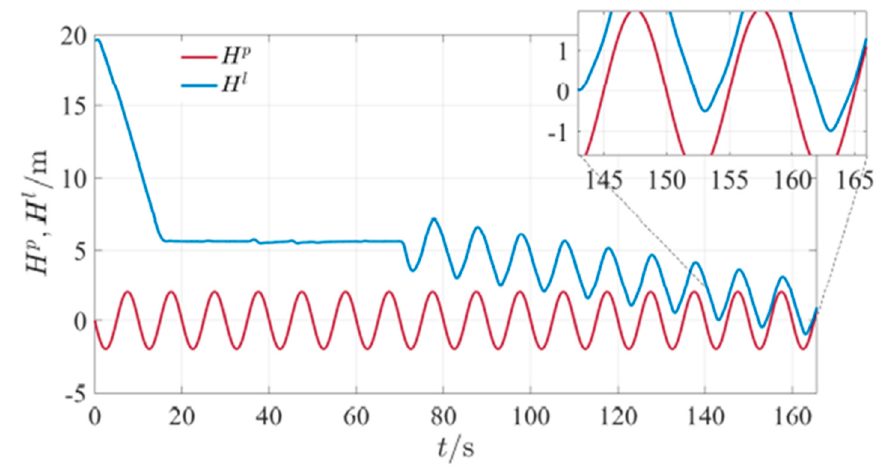
Figure 46. The evolution of H p and H l vs. time when A w = 4 m, T w = 10 s.